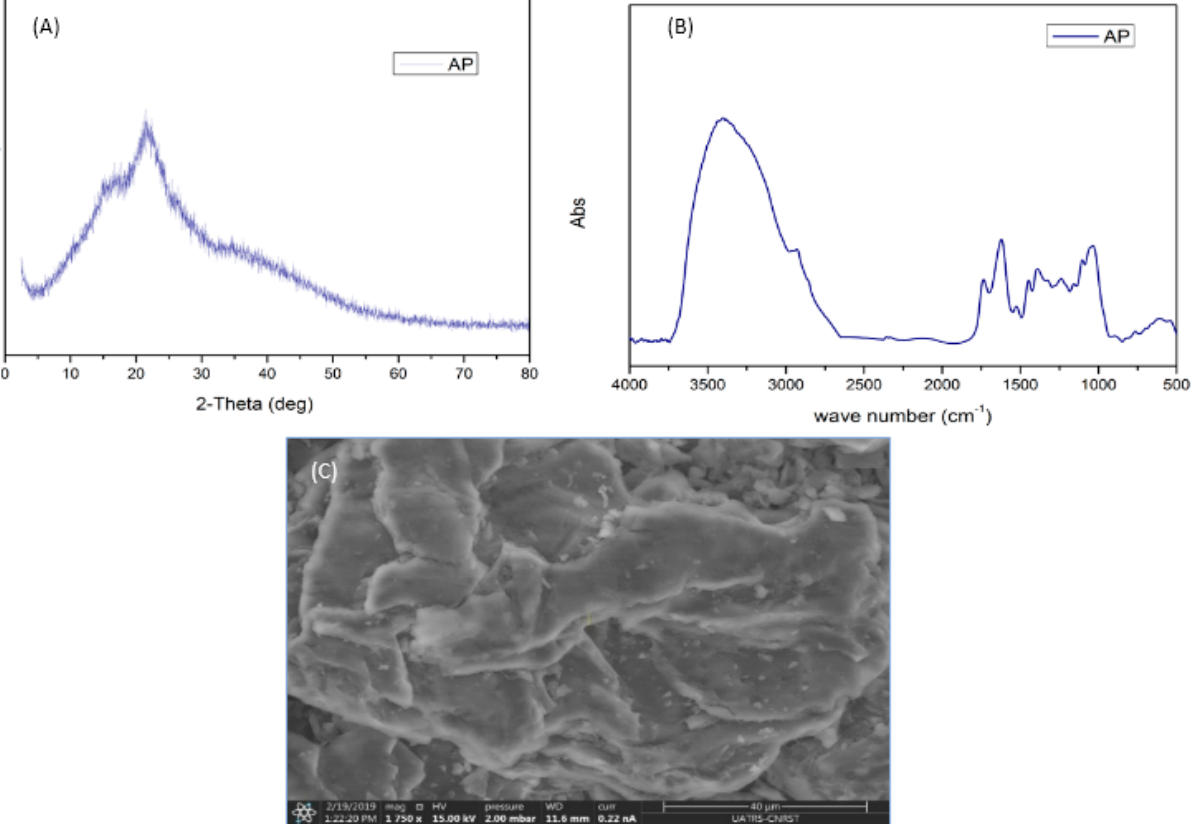
Figure 1. ( A ) X-ray diffraction patterns of AP; ( B ) FTIR spectrum of AP; ( C ) SEM image of